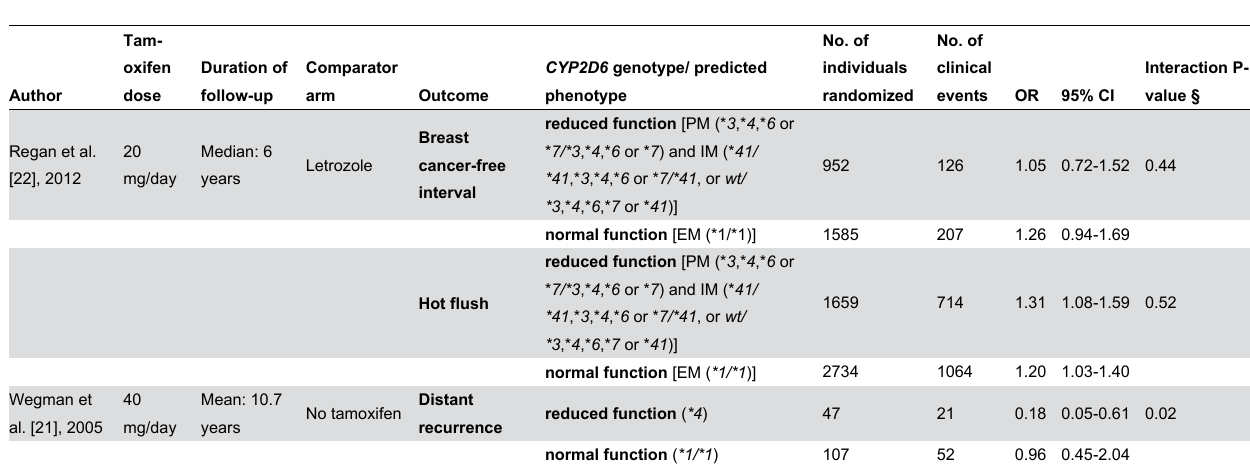
Table S2. Contribution of included studies from the systematic review to each of the composite outcomes.